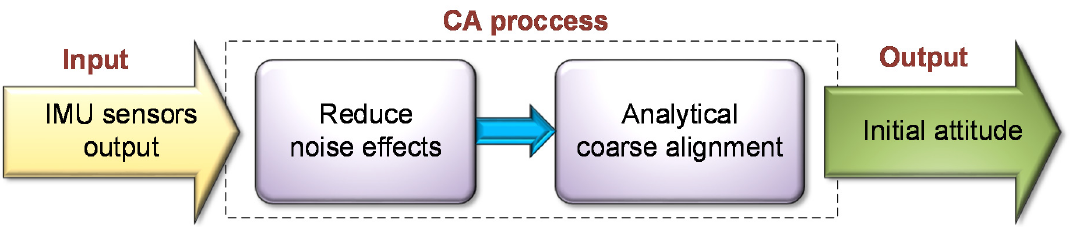
Figure 1. Traditional INS CA process.